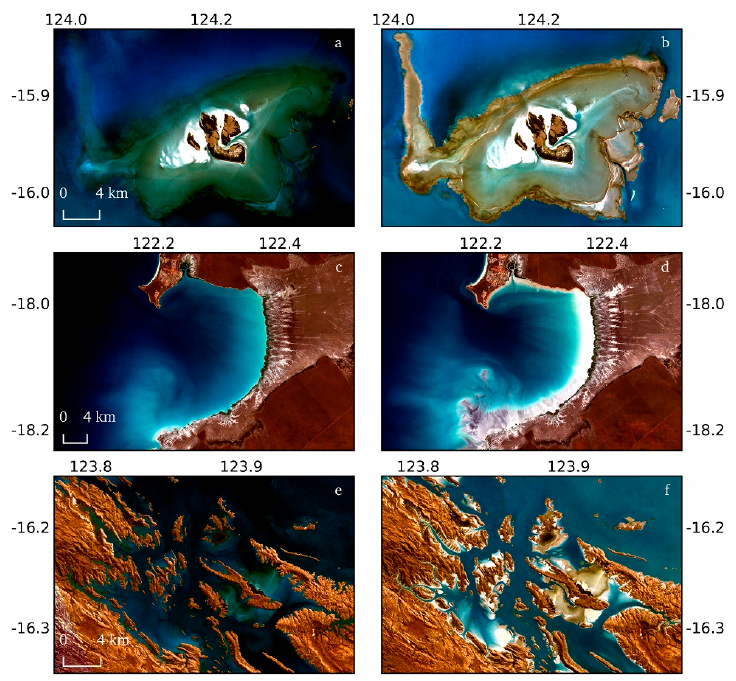
Figure 4. High and low tide composite products: pixel-based composite geomedian mosaics generated at the highest 20th percentile ( a , c , e ) and lowest 20th percentile ( b , d , f ) of the observed tidal range (OTR). Examples shown at Montgomery Reef, Western Australia ( a , b ); Roebuck Bay, WA ( c , d ), and Talbot Bay, WA ( e , f ).